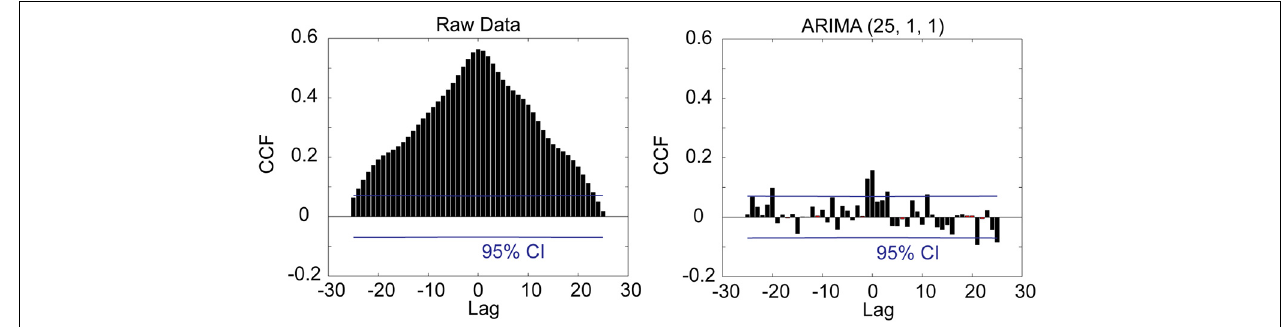
FIGURE 4 | Crosscorrelation (CCF) functions between the two LFP channels illustrated in Figure 3 for the raw data (left panel) and prewhitened data (right panel). The crosscorrelogram of the raw data is spurious.